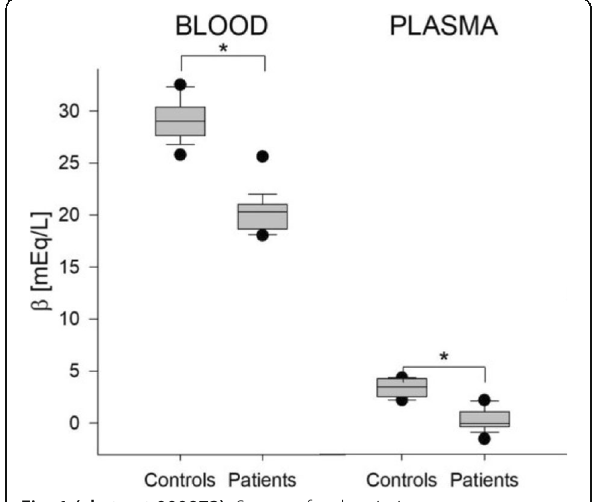
Fig. 1 (abstract 000973). See text for